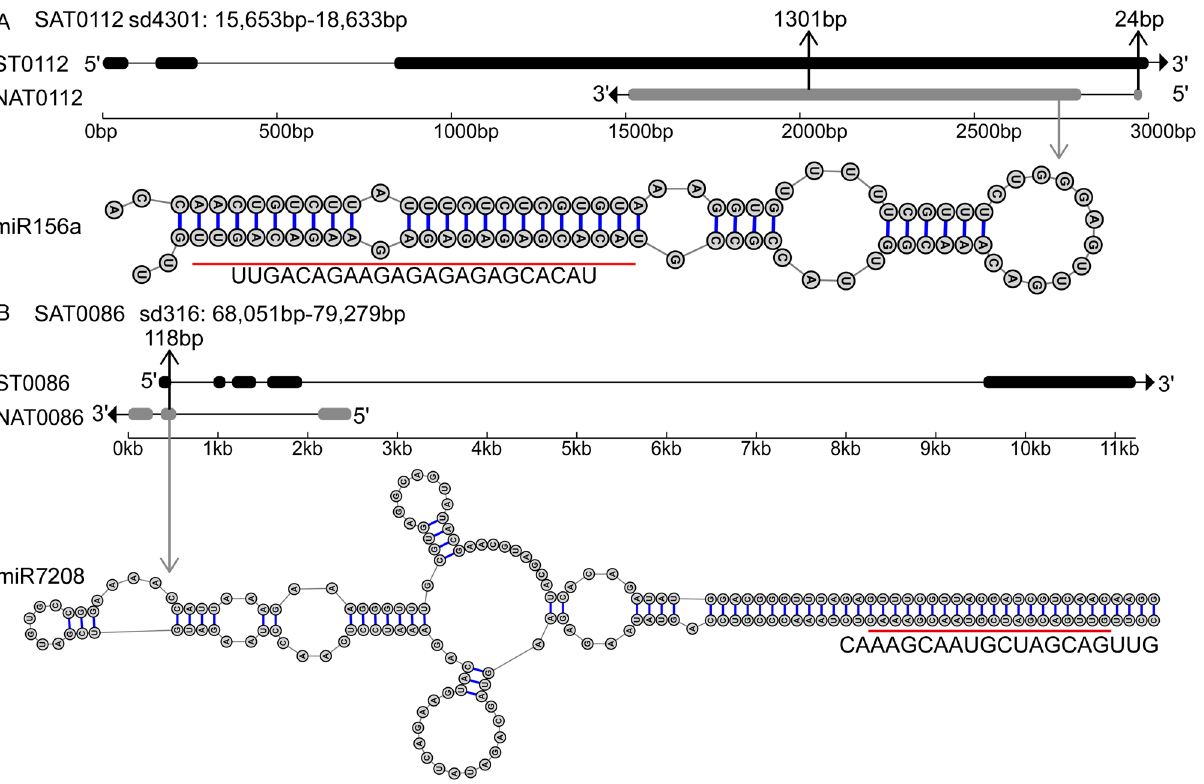
Figure 6. Gene structures of two SAT pairs and the predicted hairpin structures of pre-miRNA. ( A ) and ( B ) panels showed information about SAT0112 and SAT0086, respectively. Each panel had two parts, gene structures (above) and predicted hairpin structure (below). In gene structure, the gray and black bars represent exons of NAT and ST, respectively. The lines between bars represent introns. Arrows indicate the transcription direction. The length of the overlapping region was marked above the structure. In the part of the predicted hairpin structure, the miRNA was marked by a red line. The gene structures were drawn using GSDS v2.0 62 and the hairpin structures of pre-miRNA were drawn using RNAstructure v6.0.1 63